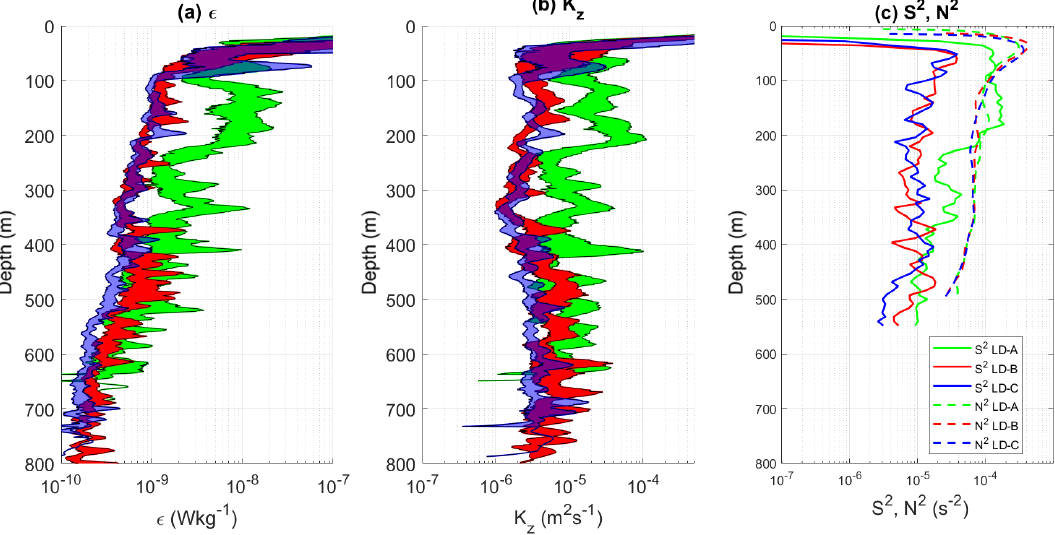
Figure 7. Mean profiles at long-duration stations: (cid:15) in (a) , K z in (b) , and S 2 and N 2 in (c) . K z was computed using N from the VMP measurements, while the profiles in (c) were inferred from the rosette-mounted CTD and LADCP instruments. The 95% confidence interval for (cid:15) and K z is displayed with a shading surface in (a) and (b) .